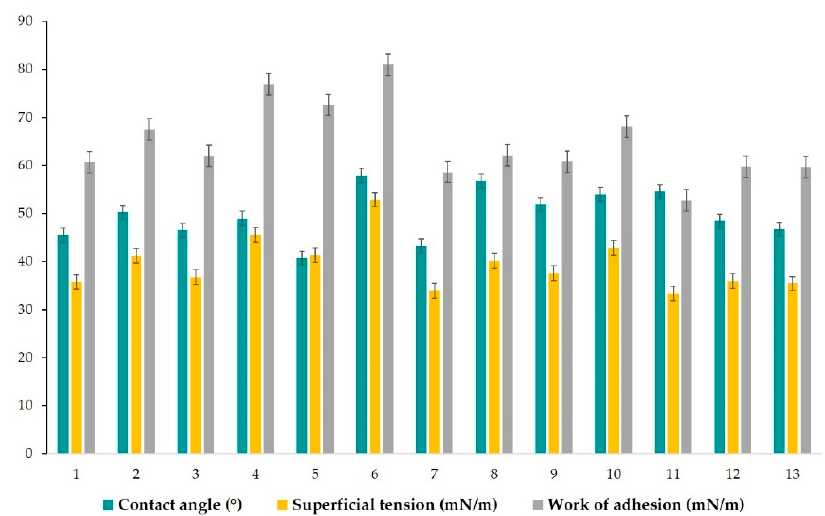
Figure 9. Representation of contact angle, superficial tension and work of adhesion and their variation, for each microemulsion (1–13) in a comparative manner, after the contact angle model study.